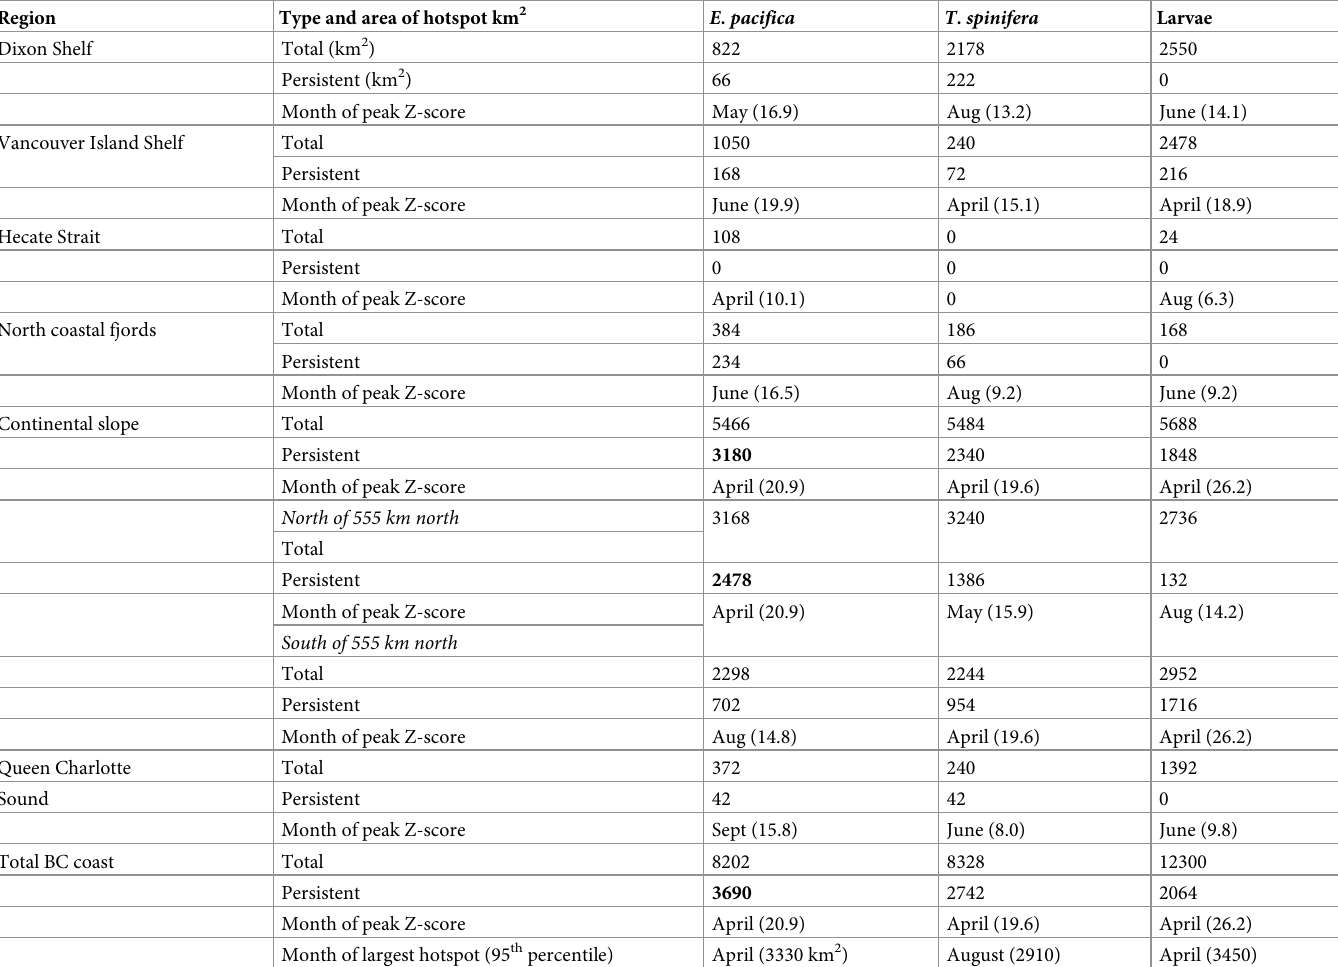
Table 3. Summary of hotspot intensity and persistence for E . pacifica , T . spinifera , and euphausiid larvae. Region